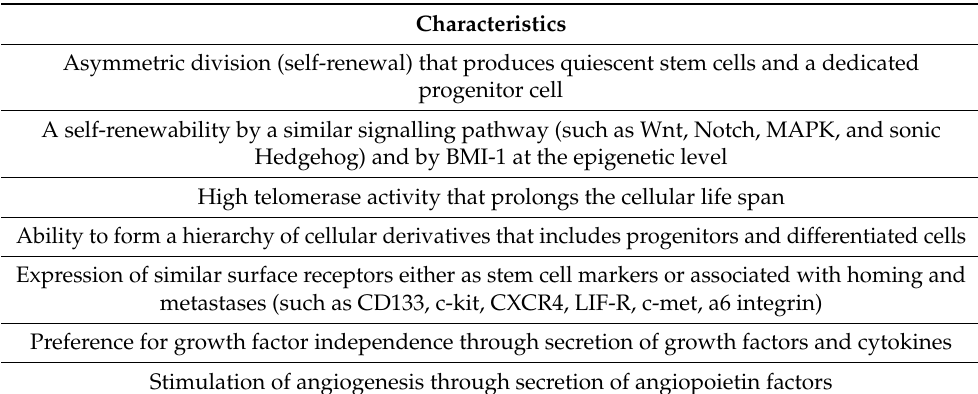
Table 1. Common characteristics of normal and cancer stem cells (Adapted from Bapat et al., 2010).